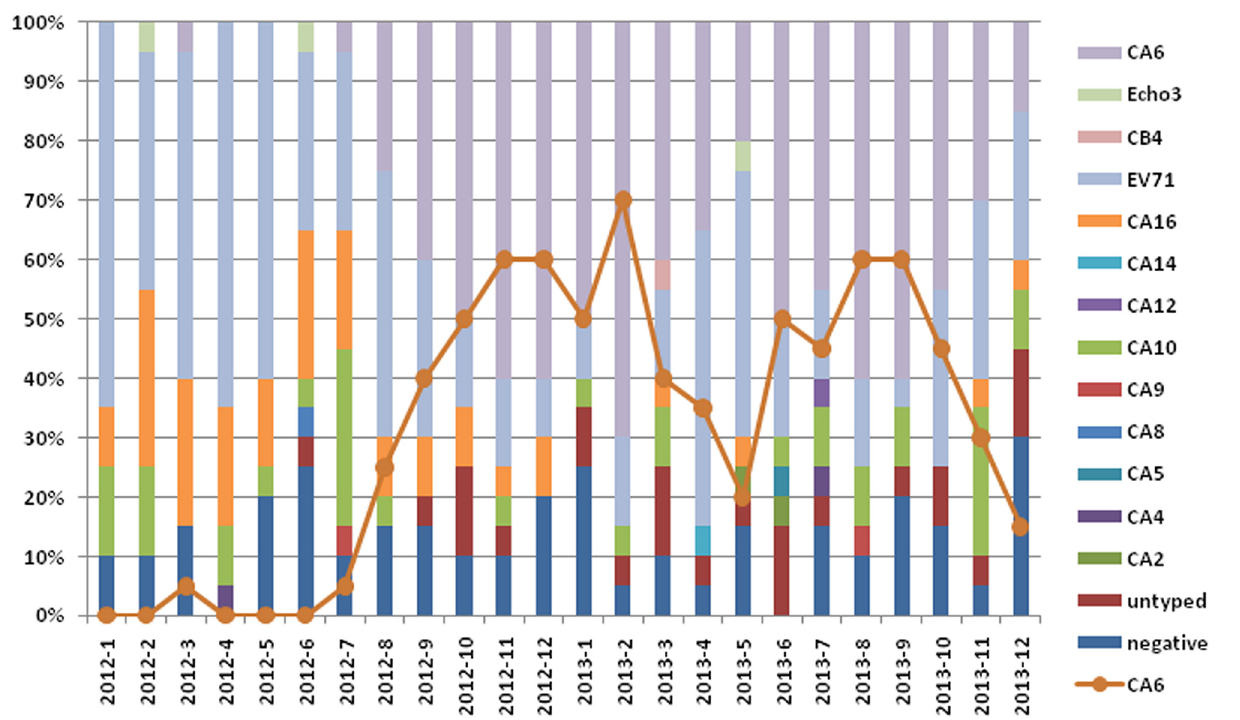
Fig 2. The temporal distribution of enterovirus genotypes identified in HFMD patients from 2012 to 2013, Shanghai,